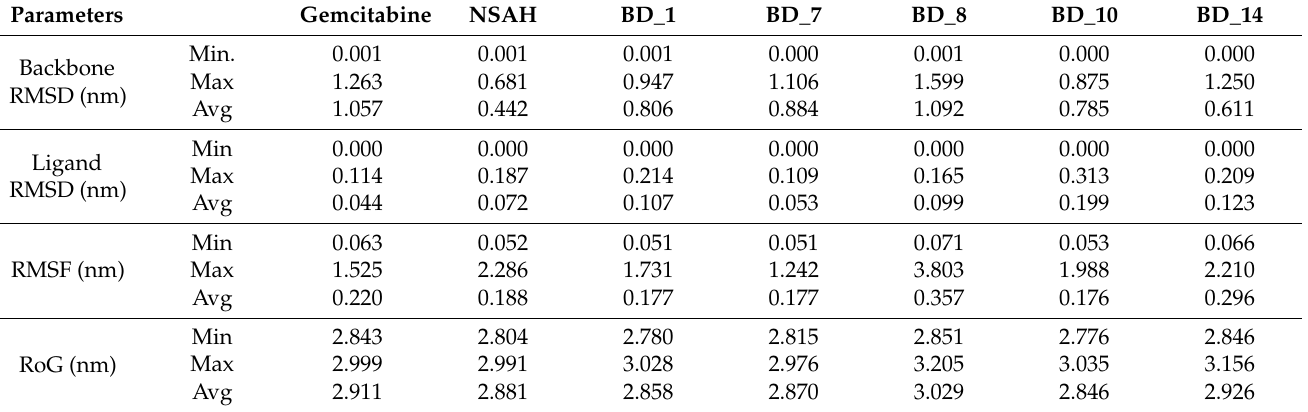
Figure 5. Binding mode in the 3D surface view of gemcitabine, NSAH, BD_1, BD_7, BD_8, BD_10, and BD_14 in hRRM1. Table 5. Statistical parameters from MD simulation trajectories for hRRM1